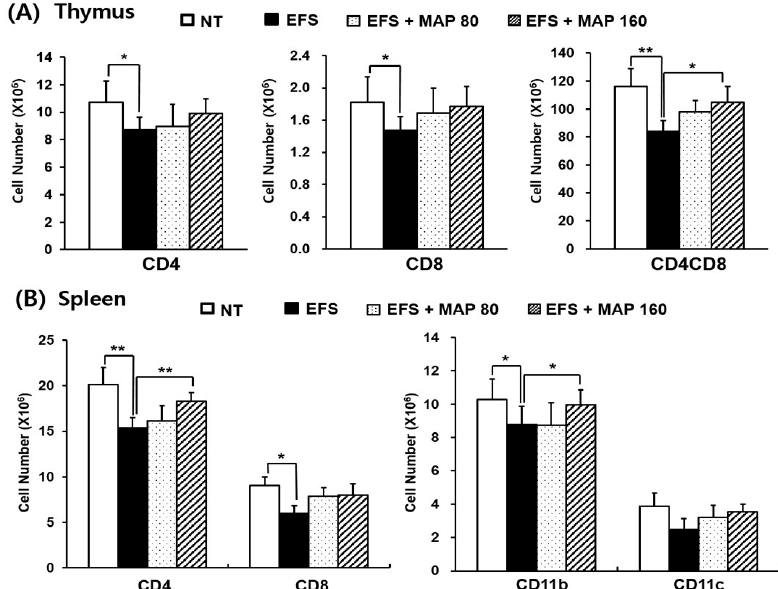
Figure 4. Protective effect of MAP against chronic EFS stress-induced disturbance of lymphocyte cellularity in OVA-immunized mice. Mice are grouped as described in Figure 1. Immunization with OVA was previously achieved in mice. Cellularity of lymphocytes in the ( A ) thymus and ( B ) spleen was analyzed using flow cytometry in which 10,000 cells were scored. Values are means ± SEM of three experiments, n = 5. * p < 0.05, ** p < 0.01 compared with control.